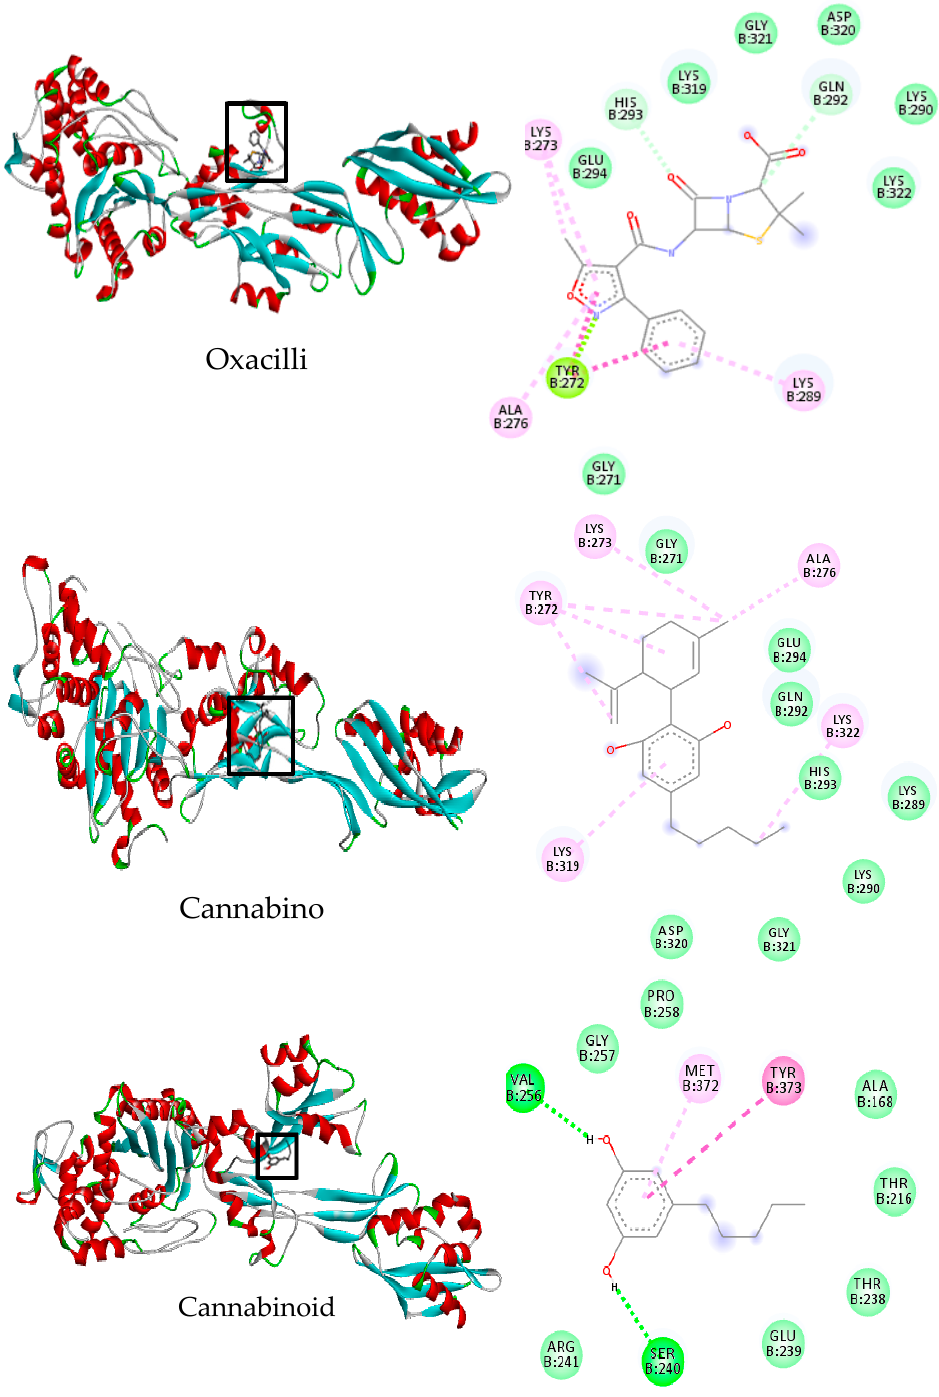
Figure 4. Left: the molecular docking for oxacillin and Cannabinoids 2 and 23 in the PBP protein. Right: the 2D diagrams of the molecular interactions in the active site.